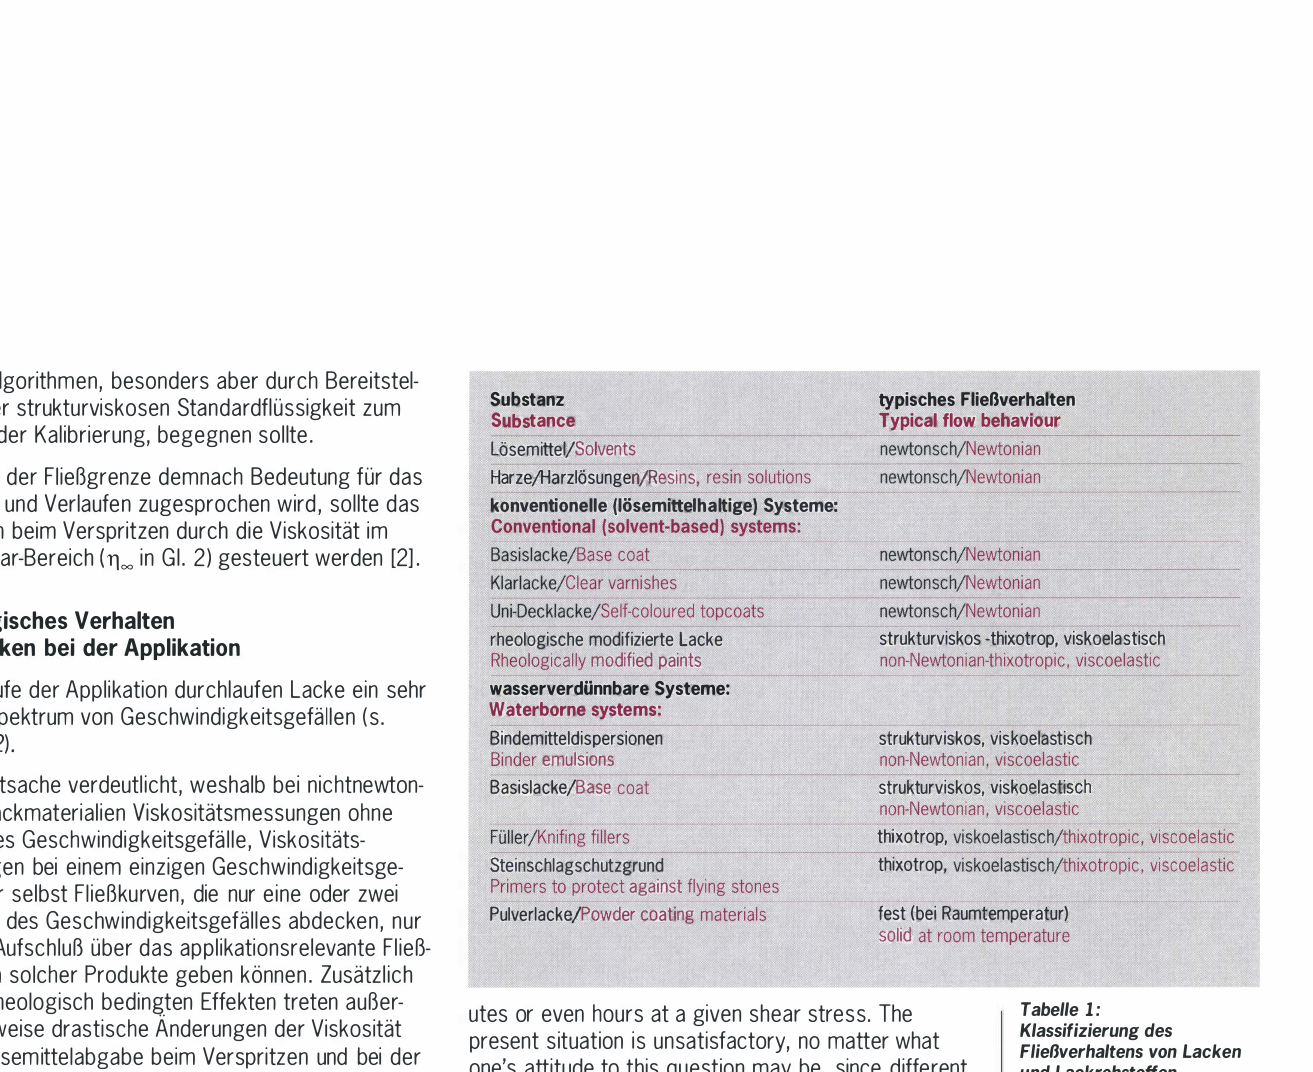
behaviour of paints and paint raw materials